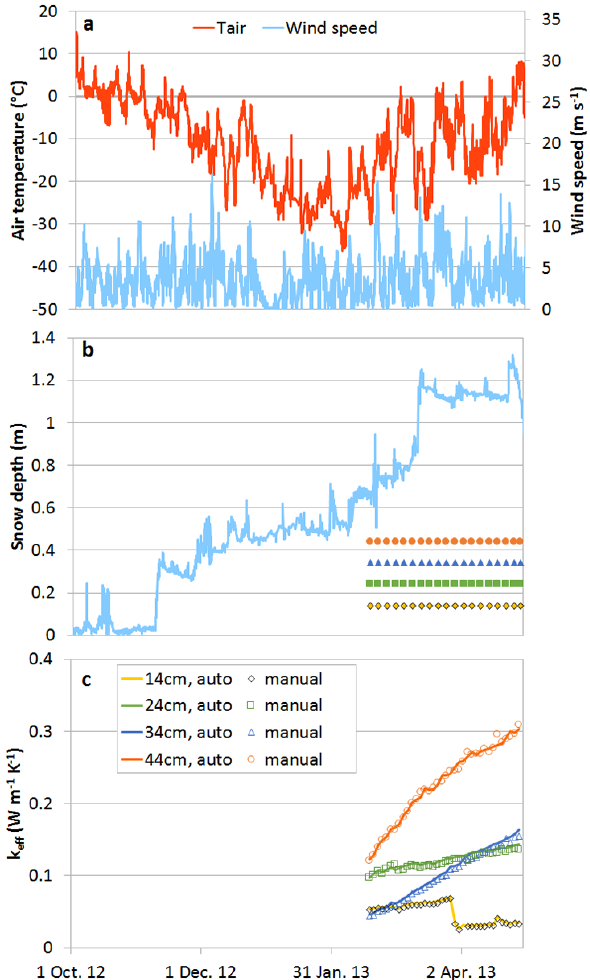
Figure 4. Meteorological and thermal conductivity data automat- ically recorded during the winter 2012–2013. (a) Air temperature and wind speed; (b) snow height and NPs height; (c) k eff time se- ries. The snow gauge is about 6m from the NPs, so that slight dif- ferences in snow heights at both spots are